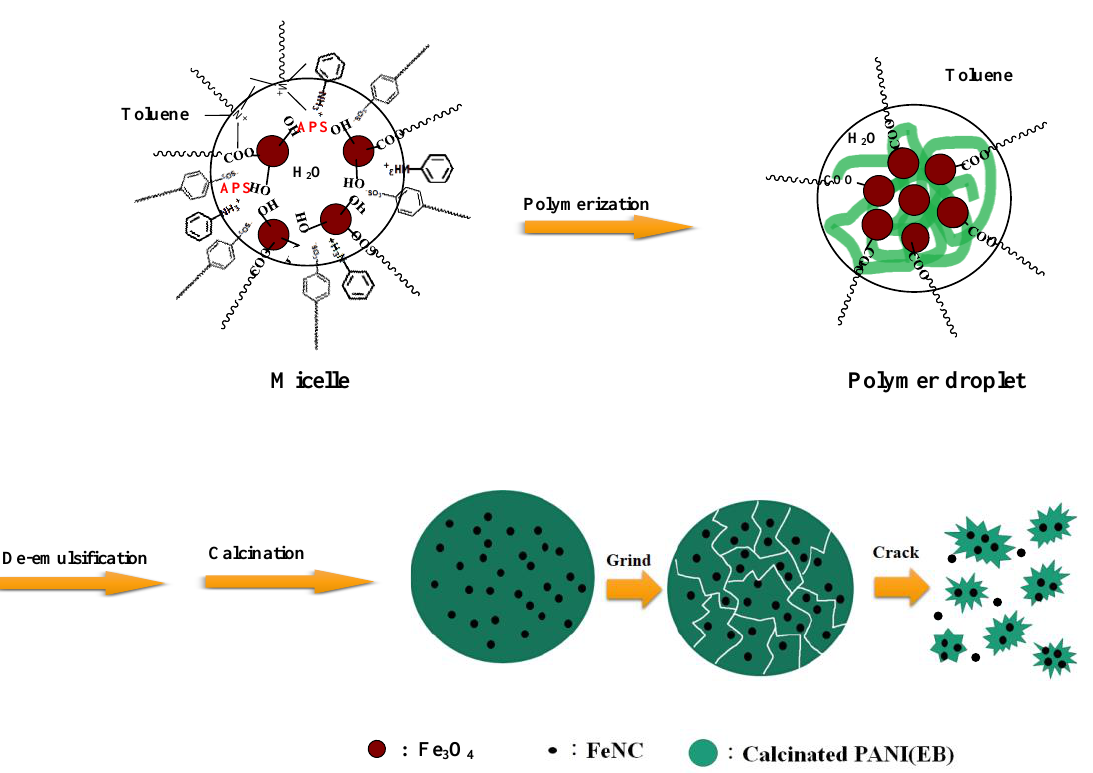
Figure 2. UV–Vis–NIR spectra of PANI(ES) and various PANI(ES)/Fe 3 O 4 (OA) composites.